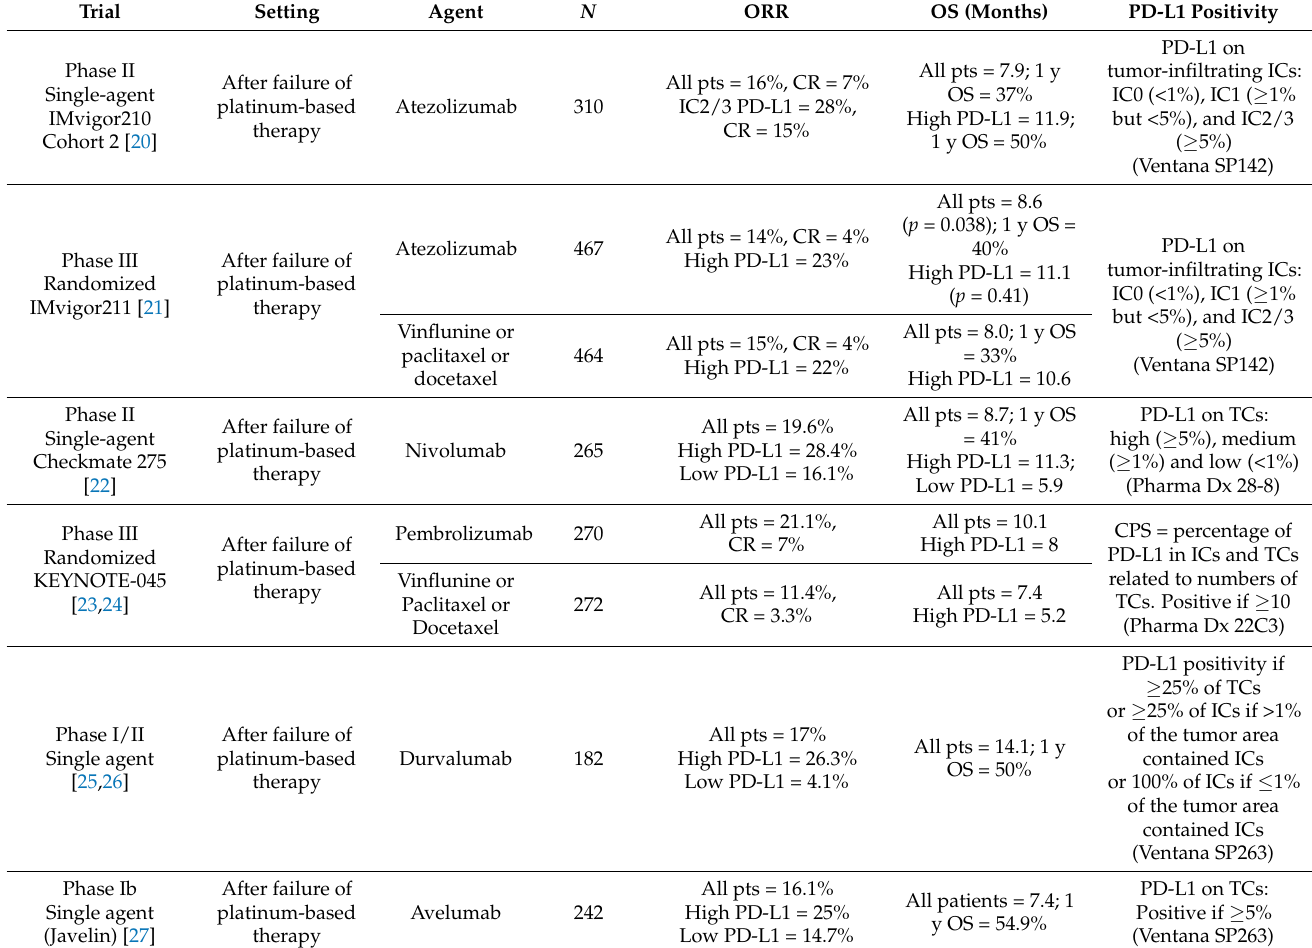
Table 1. Pivotal trials that evaluated immune checkpoint inhibitors in advanced urothelial